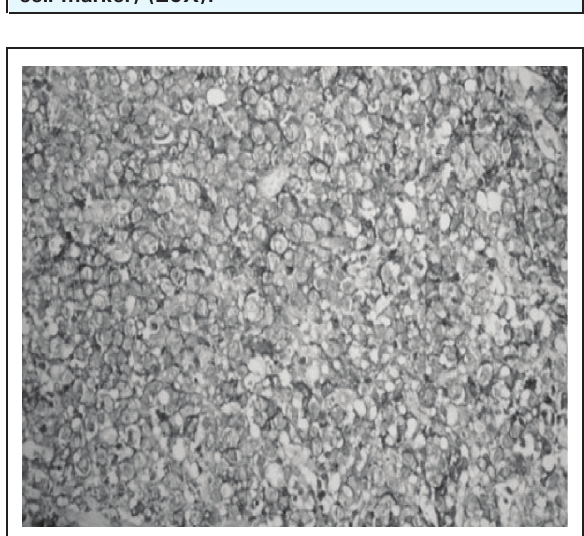
Figure 5. Photomicrograph showing membranous and cytoplasmic staining of the tumor cells by CD-20 (B- cell marker) (20X).